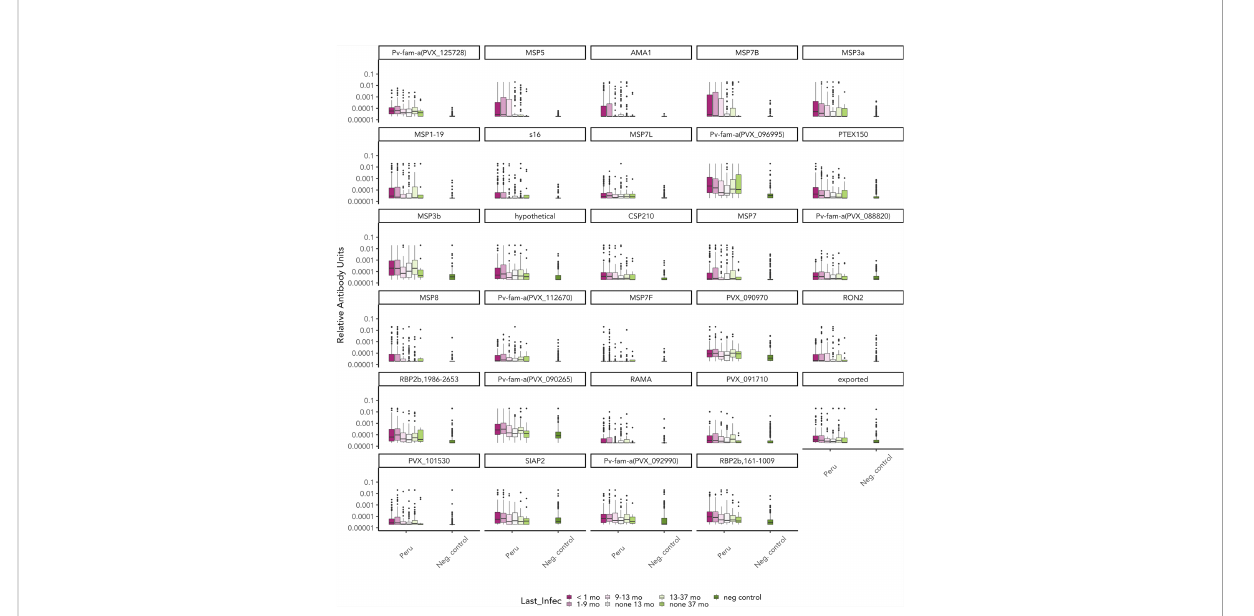
FIGURE 3 IgG3 responses to 29 Plasmodium vivax antigens of the Peruvian cohort based on time since prior P. vivax blood-stage infection. IgG3 responses to 29 P. vivax antigens were measured at the end of the Peruvian cohort (n = 590). IgG3 antibody responses are presented in relative antibody units (log) with box plots showing the median with interquartile range. The level of antibody was classi fi ed based on the prior P. vivax infection status as detected by qPCR: currently infected (<1 month) (n = 160), infected in the last 1 – 9 months (n = 228), infected in the last 9 – 13 months (n = 56), not infected within the last 13 months (n = 75), infected in the last 13 – 37 months (n = 59), and not infected in the last 37 months (n = 12). Antigens are ordered by the highest seropositivity rates (see Table